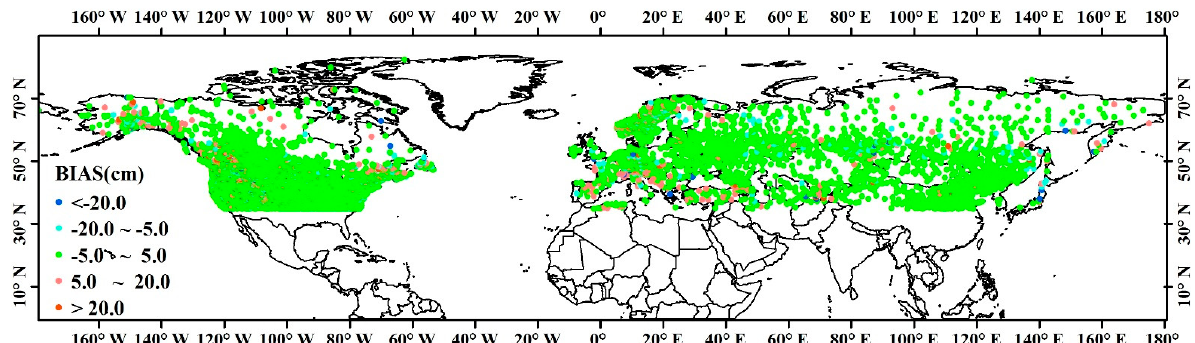
Figure 5. Histogram of the in situ observations and fused values (BIAS) distributed between the fused snow depth and in situ observations. BIAS values were divided into five classes; the num- bers in the picture indicate the quantities of each class. The fused results also show that only very few pixels have a BIAS value greater than 5.0 cm, or less than − 5.0 cm. The spatial pattern of the BIAS (Figure 6) exhibits a good consistency with station observations over the Northern Hemisphere, especially at low latitudes.